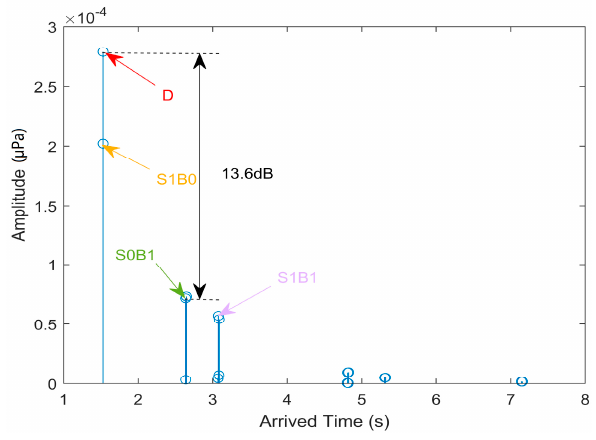
Figure 9. Time arrival structure of the eigen ‐ rays (2.4 km).